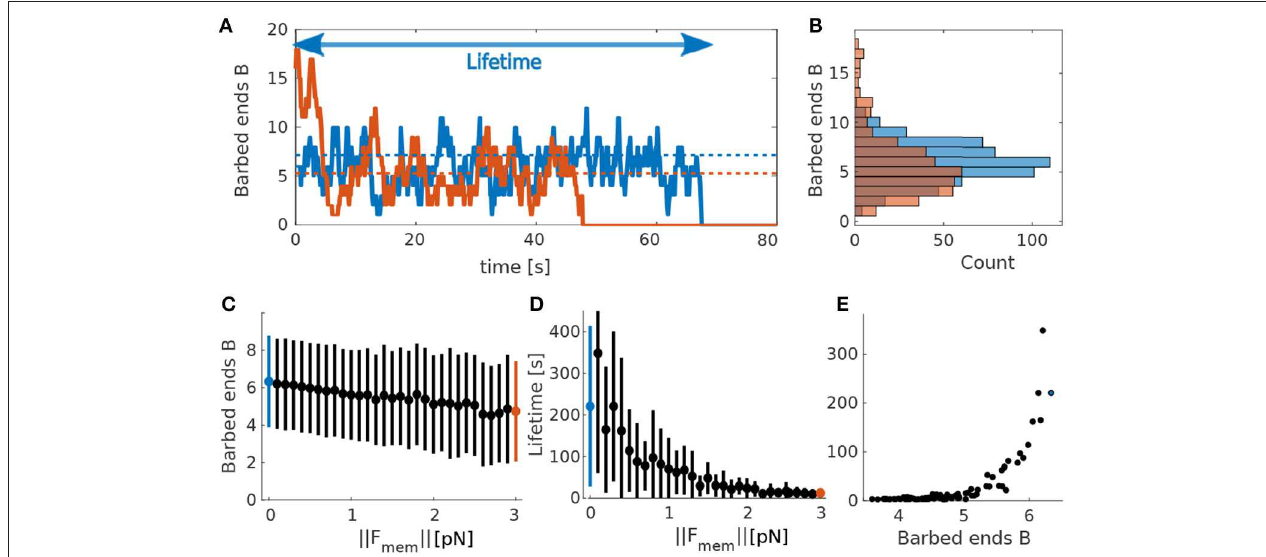
FIGURE 2 | Actin polymerization focus. (A) Evolution of barbed ends over time at a single actin polymerization focus. Blue solid line corresponds to and orange solid line to F mem 3pN. Dotted lines indicate theoretical mean values calculated using the deterministic model for barbed ends in Equation 7. Colors || || = correspond to the different values of F mem . Arrow indicates the lifetime of the focus corresponding to the blue curve. (B) Occurrence frequency (x-axis) of each || || number of barbed ends (y-axis) over all time-steps (of length 1 t ) in (A) . Colors as in (A) . (C) Mean and standard deviations of mean number of barbed ends B over 50 simulations each for different values of F mem . (D) Same for focus lifetimes. Blue and red dots mark the force values used in (A,B) . (E) Mean lifetime over mean || || number of barbed ends for 50 simulations varying force values.